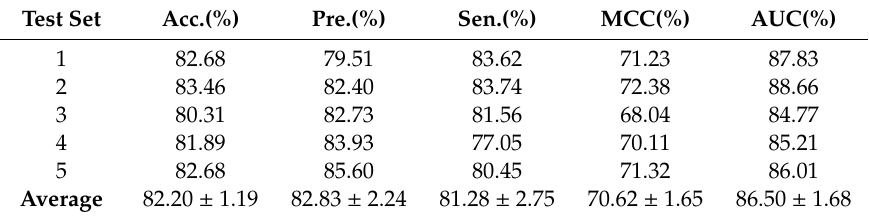
Table 3. The five-fold cross-validation results achieved on GPCR dataset by using the proposed model.